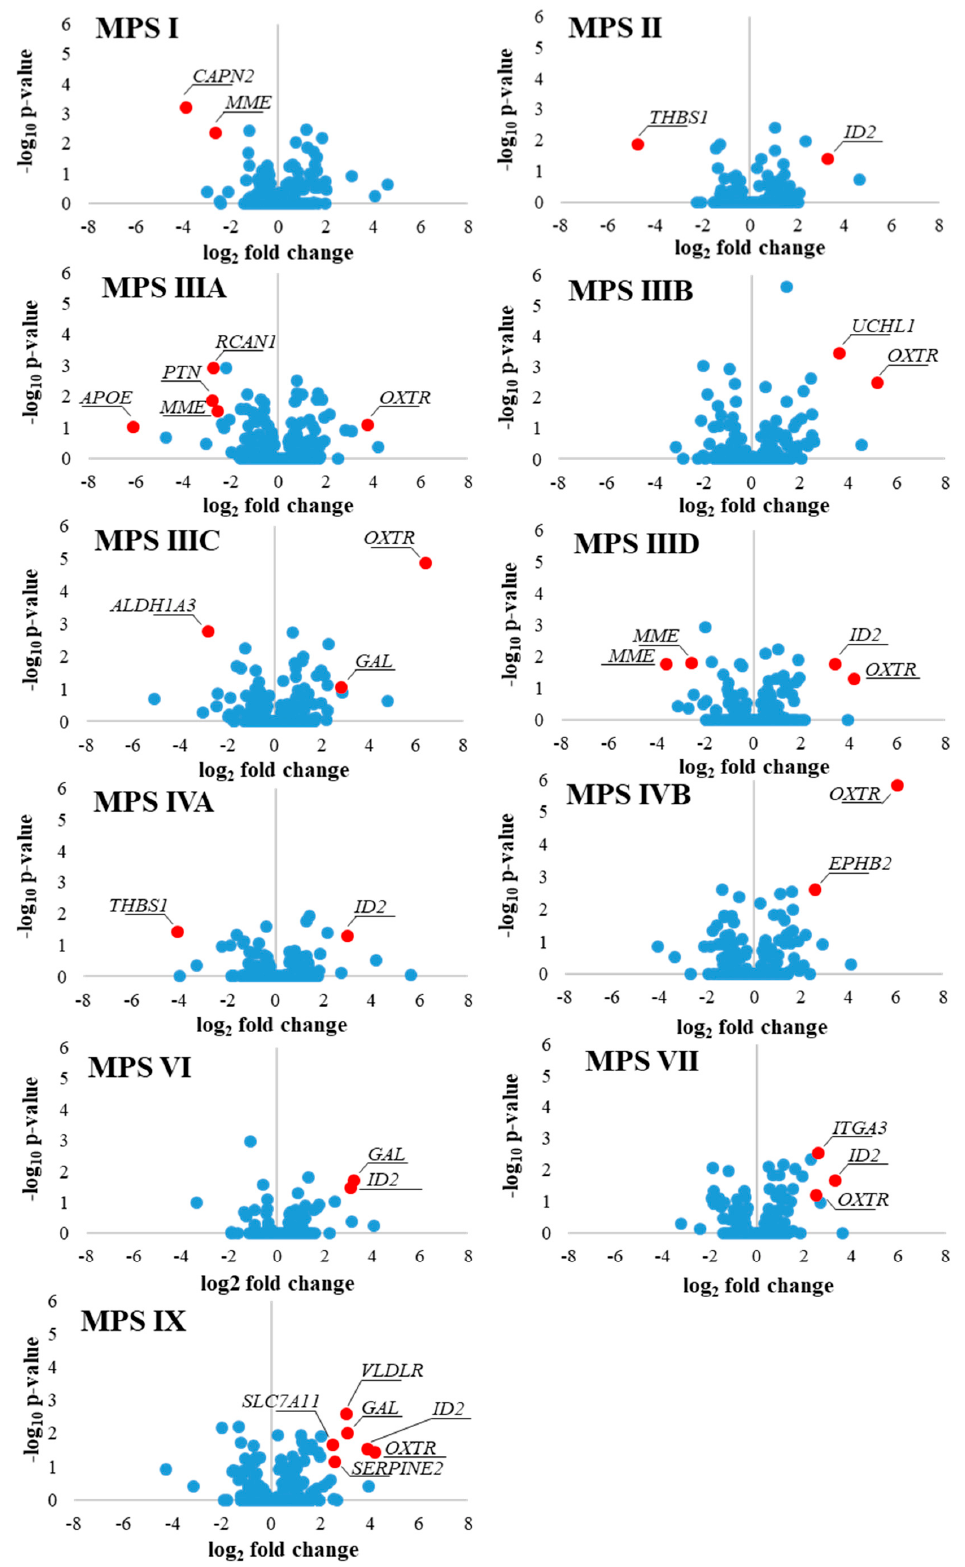
Figure 4. Volcano plots indicating genes which expression is significantly changed in MPS types relative to control cells (HDFa) and reached log 2 FC > 2.5. The gene ( MME ) for which two alternative transcripts were changed in the above manner is indicated in MPS IIID.